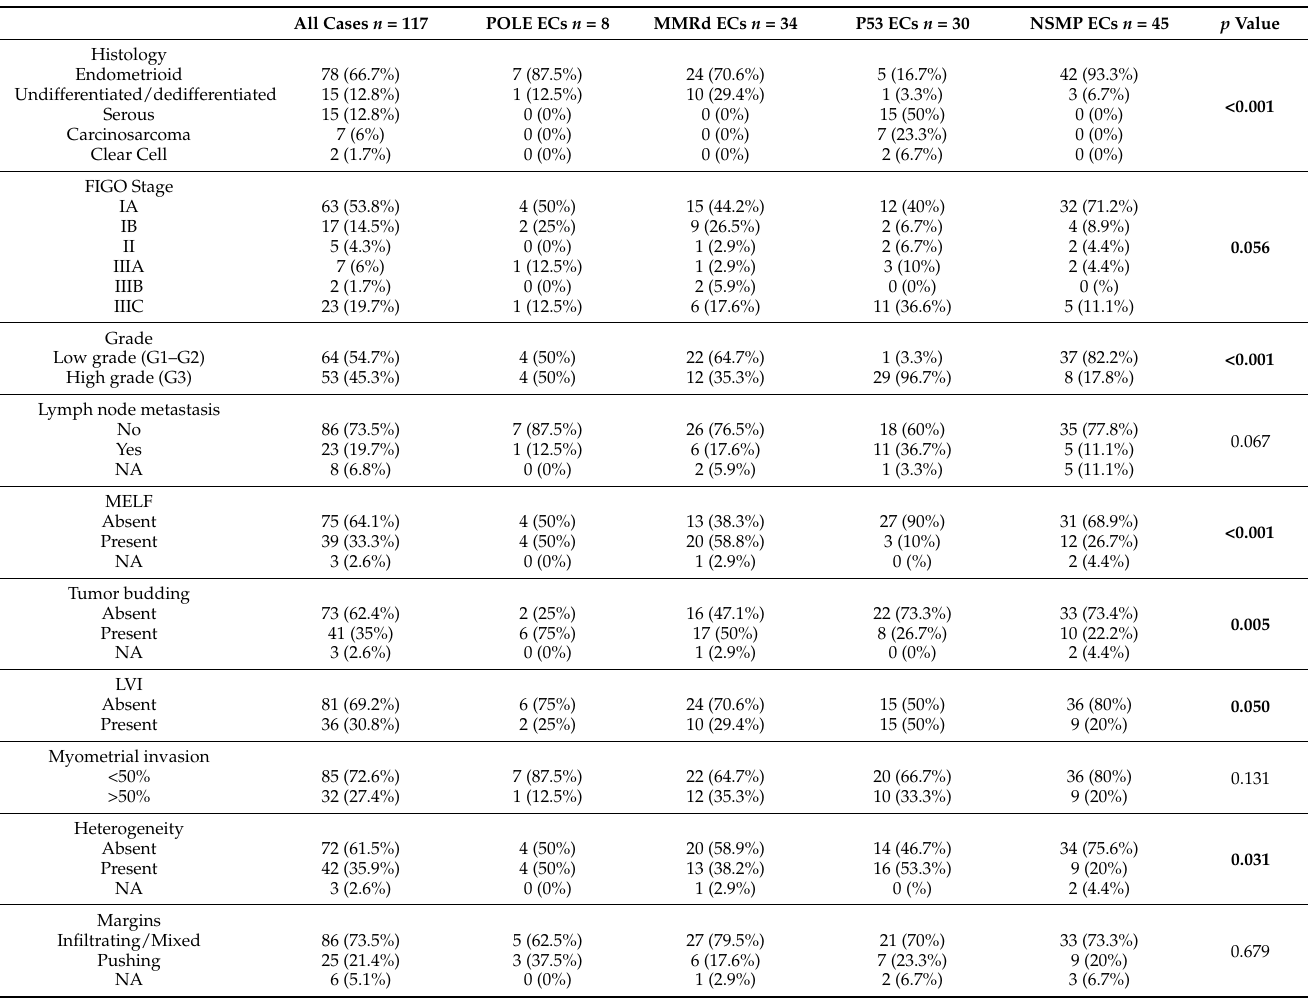
G: grade; FIGO: International Federation of Gynaecology and Obstetrics; LVI: lymph-vascular space invasion; MELF: microcystic, elongated, and fragmented; MMRd: mismatch repair deficiency; NA: not available; NSMP: